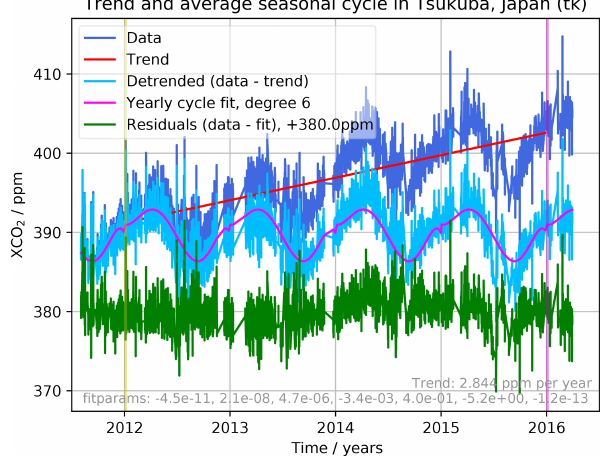
Figure 1. Detrending and deseasonalization of the XCO 2 total col- umn measurements in Tsukuba, Japan. The data shown are indi- vidual measurements. The trend (shown as a red “trend” line) is removed with a linear least-squares fit to the data from background directions between 1 January 2012 and 1 January 2016 (denoted by the yellow and magenta vertical lines), the seasonal cycle from the signal due to photosynthesis, respiration, and decay (shown as “yearly cycle fit, degree 6”) is removed by fitting a polynomial of degree 6 to the combined yearly cycles of the detrended data. De- gree 6 was chosen empirically to minimize structure in the residuum over all TCCON